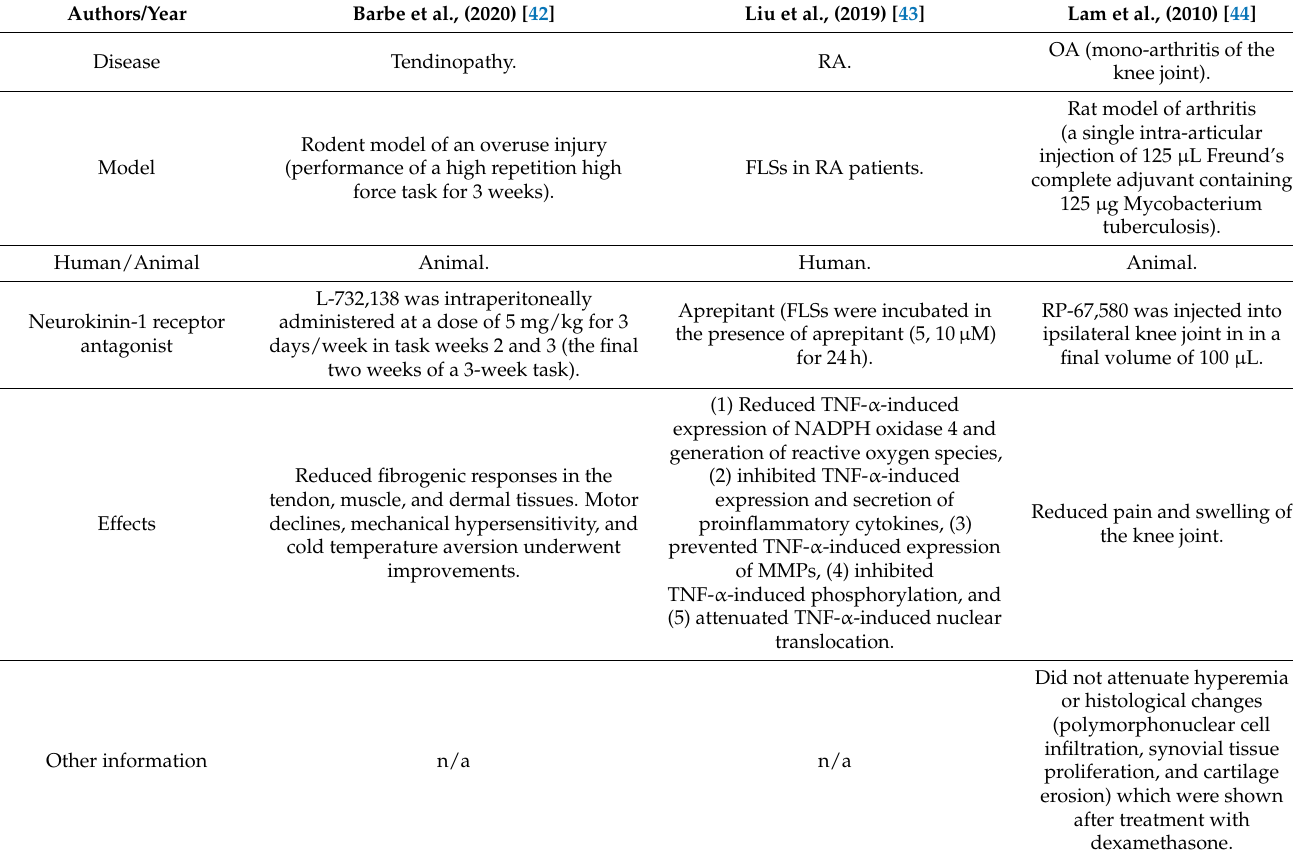
Table 1. Recent studies on the use of neurokinin-1 receptor antagonists in musculoskeletal disorders.